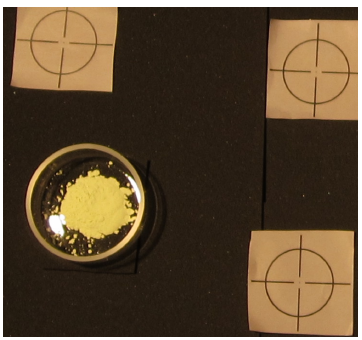
Figure 2. Holmium-oxide powder in the laboratory HySpex setting in a quartz glass petri dish underlain by black cellular rubber. Ge- ometric markers for the pre-processing were placed alongside the sample.